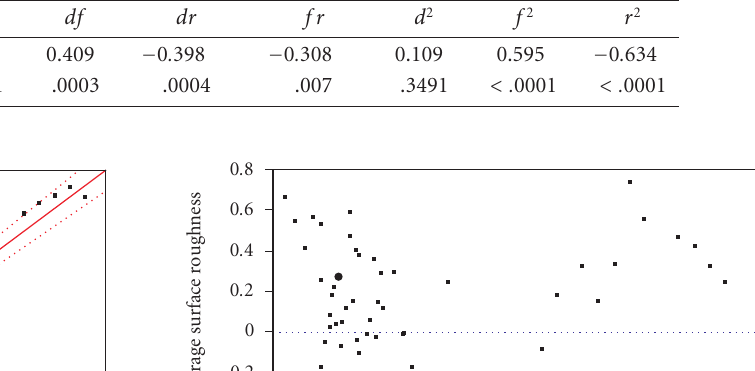
Table 10: Pearson correlation coe ffi cients of second-order regression model.